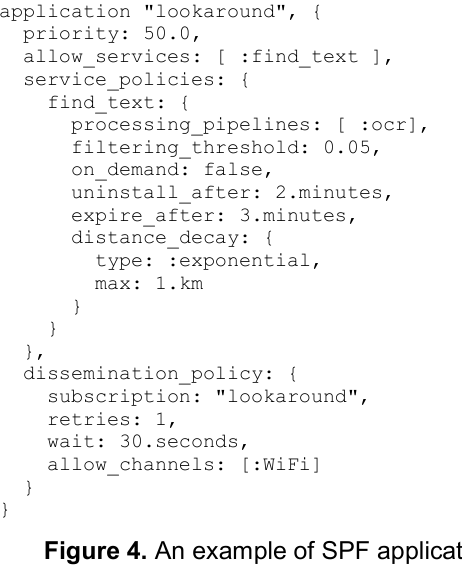
Figure 4. An example of SPF application configuration.